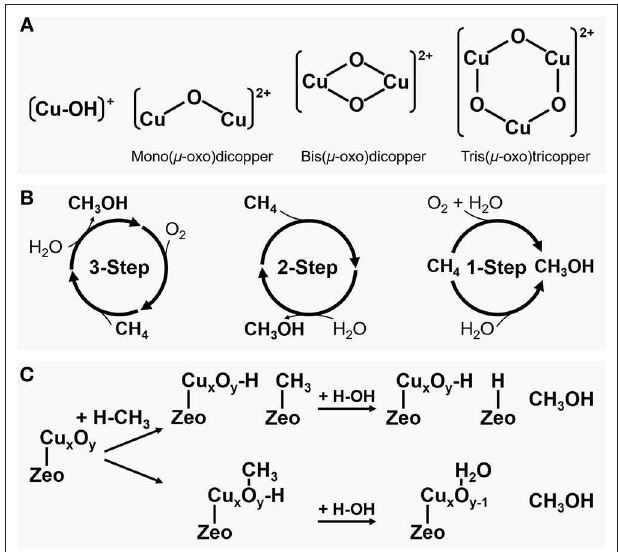
FIGURE 1 | (A) Proposed copper active species formed inside the zeolite pores: (from left to right) a monovalent copper oxygen species attached to one zeolite framework Al, a divalent copper-oxo cluster forming one extra framework µ -oxo bridge attached to two zeolite framework Al, a divalent copper-oxo cluster forming two extra framework µ -oxo bridge attached to two zeolite framework Al, and a divalent copper-oxo cluster forming three extra framework µ -oxo bridge attached to two zeolite framework Al; (B) Schemes for direct methane oxidation to methanol; and (C) Two possible mechanisms of methanol production via partial oxidation of